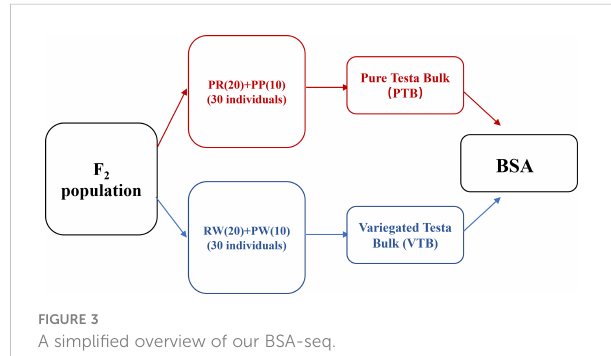
FIGURE 3 A simpli fi ed overview of our BSA-seq.